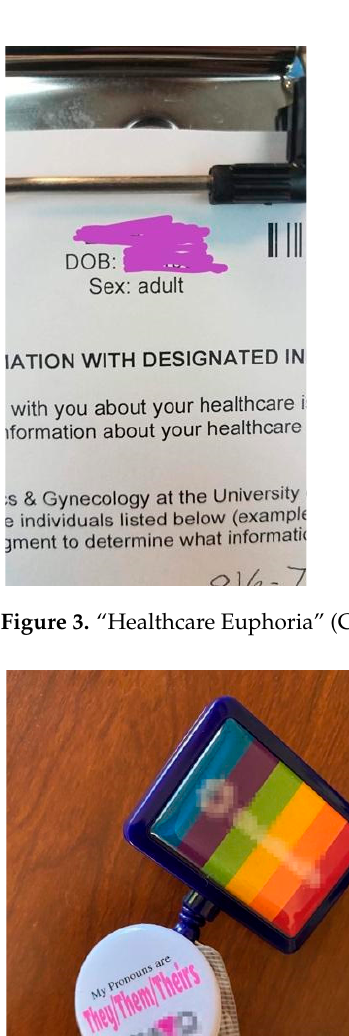
Figure 5. “We Don’t Have a ‘Men’s’ Bathroom” (Rowan). Improve Research and Provider Education on Transitional Care. PRs wanted to know more about their options for medical transition care and wanted to have knowl- edgeable providers with whom to discuss these options. Specifically, PRs wanted more nonbinary transitional care options, such as microdosing Estrogen similar to the increas- ing practice of microdosing Testosterone, which was noted as also not regularly discussed by providers. For Kai, microdosing was the best fit for them—"because I wanted to be more androgynous, my doctor set me up with a low dose of testosterone…which has been great and honestly I’ve never been happier since I’ve been on it”. The need for access to a variety of nonbinary-inclusive resources was agreed upon, particularly for making in- formed decisions about their gender-related care. The fact that [access to gender-affirming resources] is becoming so normalized is great and the fact that I get to have all of these tools is really incredible…[as] more people are able to get things they need to be more themselves…I can only imagine how much hap- pier people [will be] because of that—I know I am. (Kai) (see Figure 6)